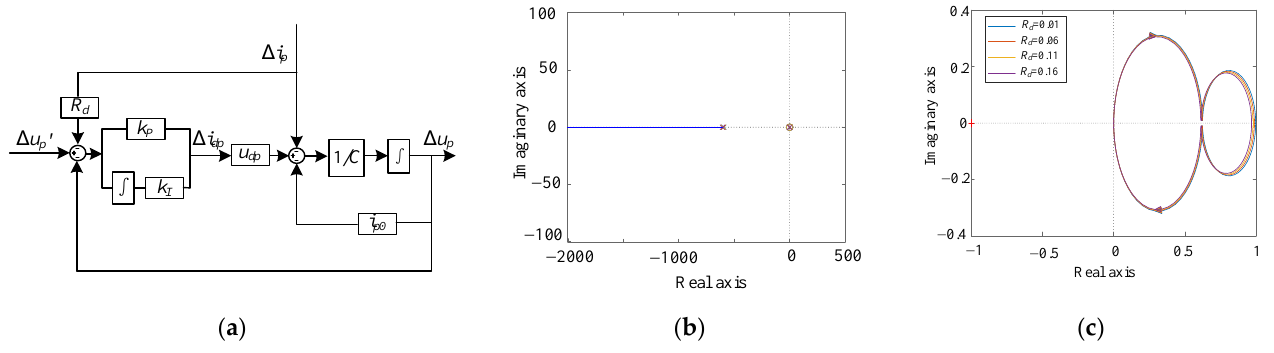
Figure 8. ( a ) The structure, ( b ) root locus, and ( c ) Nyquist plot of the primary control system with the droop coefficient in the bipolar DC distribution network. Table 2. The parameters of the bipolar DC distribution network.